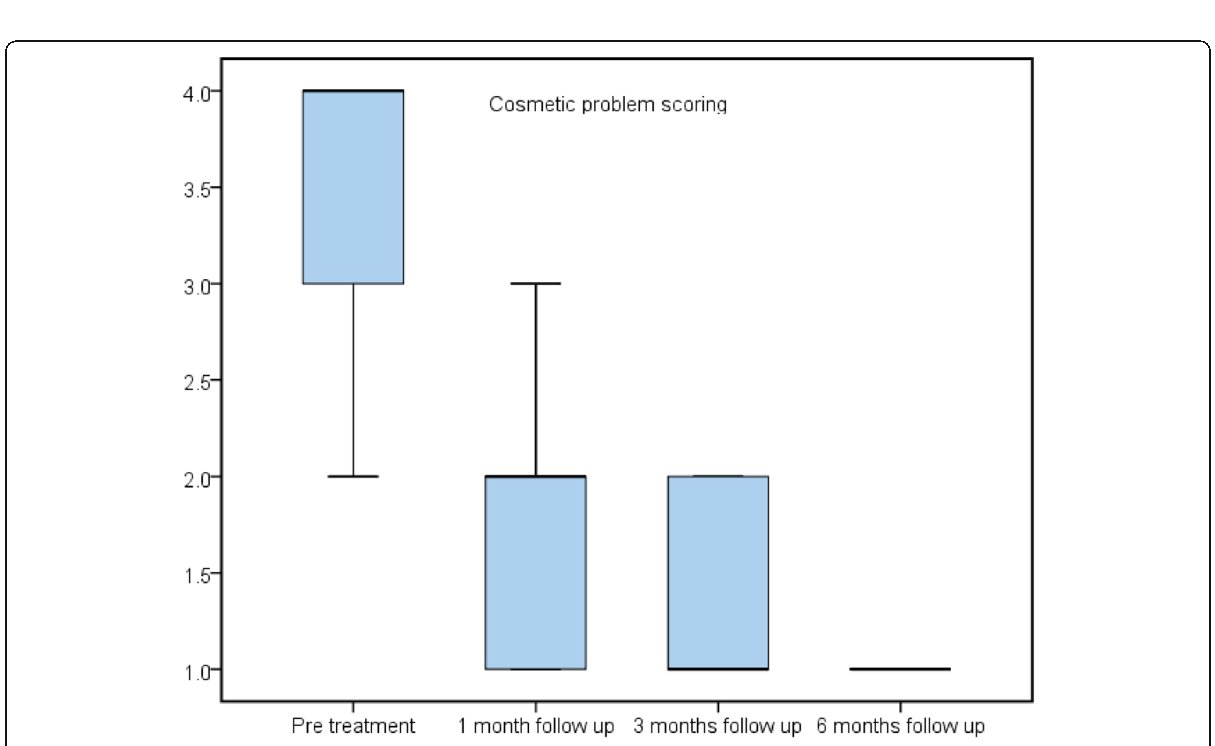
Fig. 6 Decreasing of the cosmetic problem scoring at 1, 3, and 6